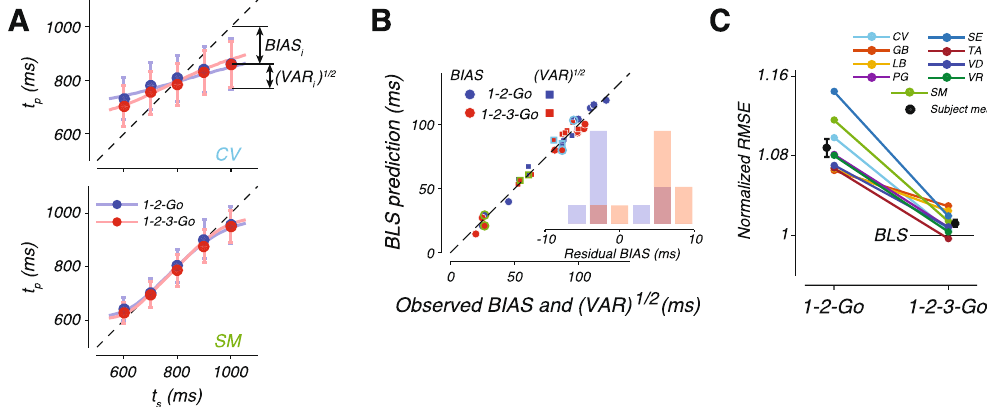
Figure 4. BLS model fits to data. ( A ) Behavior of two subjects and the corresponding BLS model fits with the same format as in Fig. 2A,B. ( B ) BIAS (circles) and VAR (squares) of each subject (abscissa) and the corresponding values computed from simulations of the fitted BLS model (ordinate). Red and blue points correspond to 1-2-Go and 1-2-3-Go, respectively. The dotted line plots unity. Data points corresponding to subjects SM and CV are marked by light green and light blue, respectively. Inset: difference between the BIAS observed from data and that expected by the BLS model fit for 1-2-Go (blue) and 1-2-3-Go (red) conditions. ( C ) Comparison of behavioral performance to model predictions. Each line connects the RMSE for 1-2-Go (left) and 1-2-3-Go (right) conditions for one subject. To facilitate comparison across subjects, RMSE values for each subject were normalized by the RMSE of the BLS model in the 1-2-3-Go condition. The black circles and error bars correspond to the mean and standard error of the normalized RMSE across subjects. See also Supplementary Figs 1, 2, and